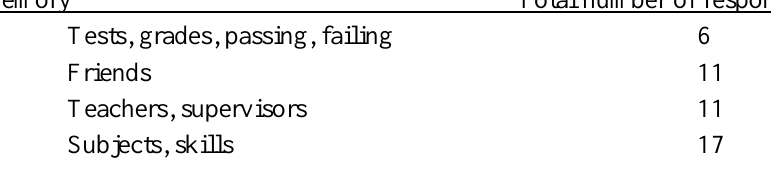
Distribution of Learning Experience Memories